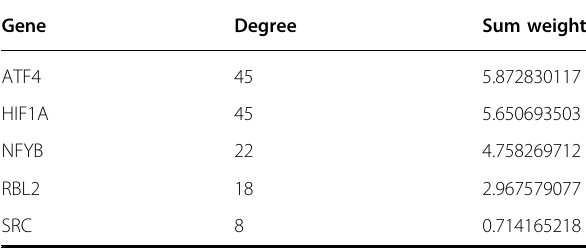
Table 2 The core degree of each input gene in the PPI network.